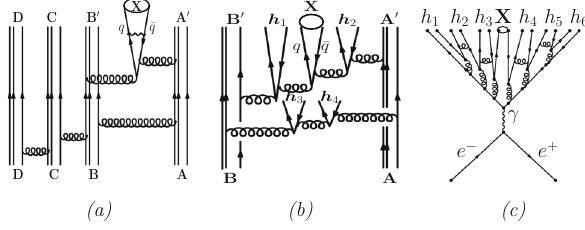
Fig. 32 Feynman diagrams for the production of a QED mesons X and hadrons h i in a low-energy 4 He ∗ and 8 Be ∗ decays, b a